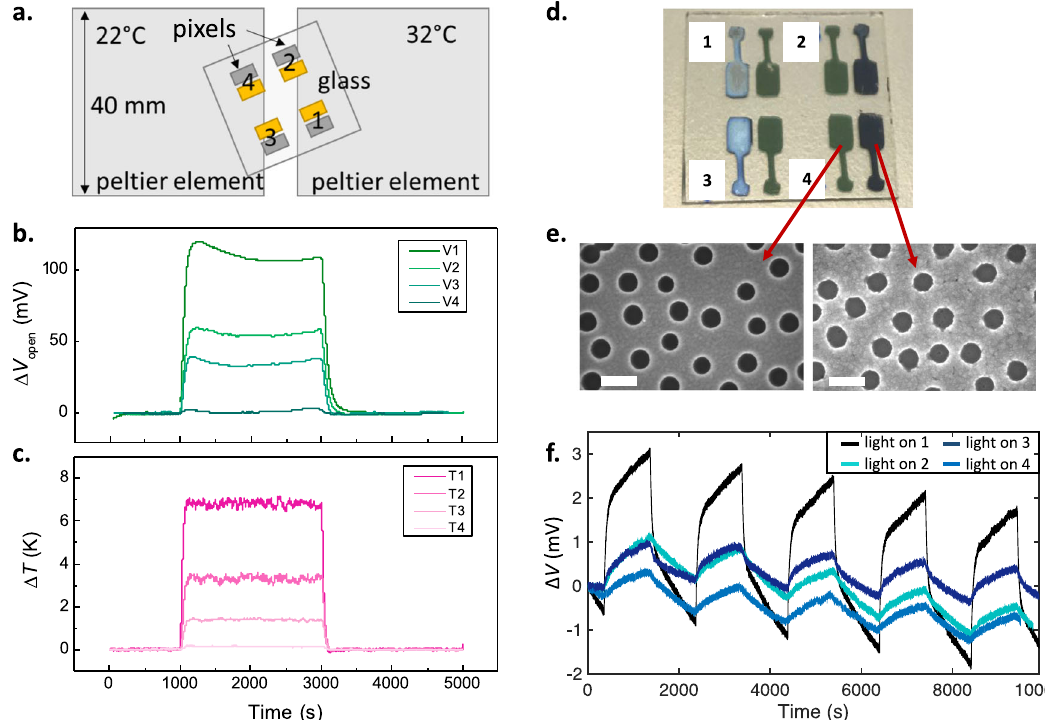
Fig. 3 Heat mapping using arrays of EATS and metasurface-based pixel arrays. a Schematic illustration of the sensor device and setup for non-uniform heating of the sample using two Peltier elements. The effective size of each Al/Au pixel is 24 mm 2 . b Voltage variations of the different pixels (V1 – V4), at RH = 30%. c Temperature evolution of the pixels in b monitored by traditional TC placed close to the pixels (T1 – T4). d Photograph of a 2 by 2 array of metasurface-modi fi ed pixels. e SEM images of a gold metasurface nanohole electrode (left) and an aluminum metasurface nanohole electrode (right). The scale bars represent 200 nm. f Sensor response for pixel 1 upon illumination of the different plasmonic EATS by a solar simulator (at room humidity without